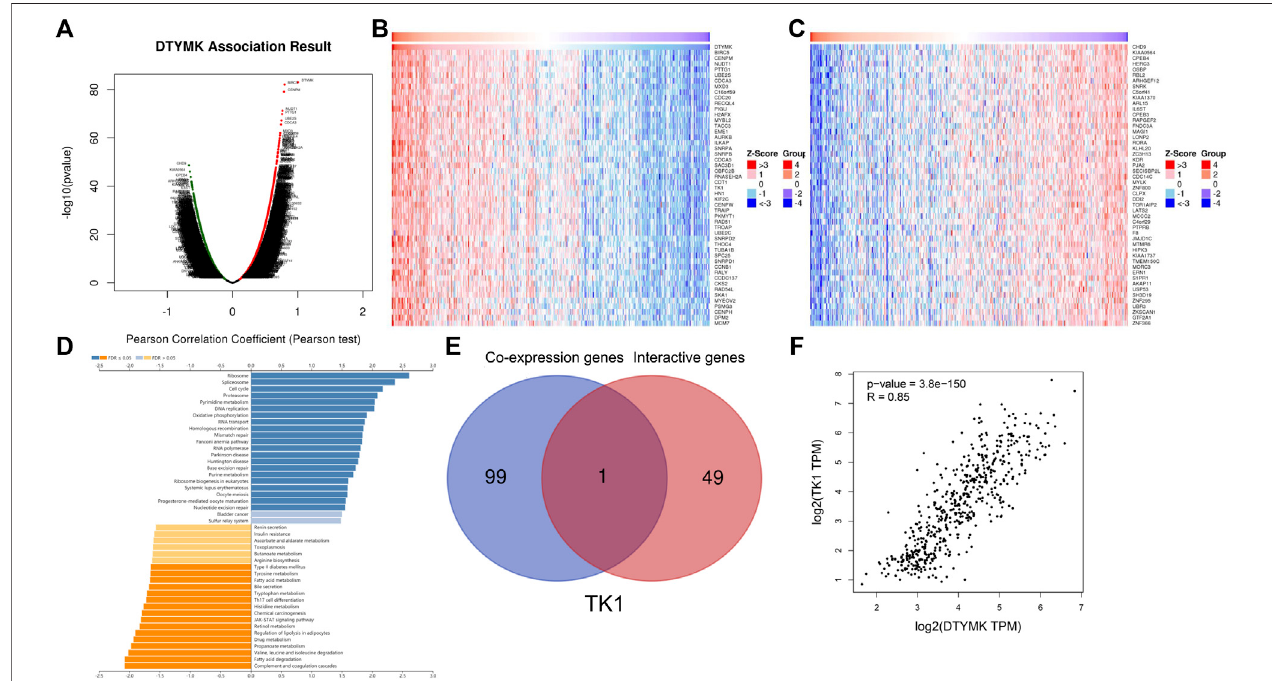
FIGURE 8 | Analysis of DTYMK co-expressing genes in liver hepatocellular carcinoma. (A) DTYMK co-expressing genes were shown by Volcano plot. Top 50 genes that positively (B) and negatively (C) correlated with DTYMK are shown by heatmap plot. (D) Gene Set Enrichment Analysis (GSEA) of DTYMK co-expressing genes. (E) Common gene thymidine kinase 1 (TK1) was obtained by the intersection of DTYMK interactive genes and DTYMK co-expressing genes. (F) The relation between DTYMK expression and TK1 expression was validated by GEPIA database.